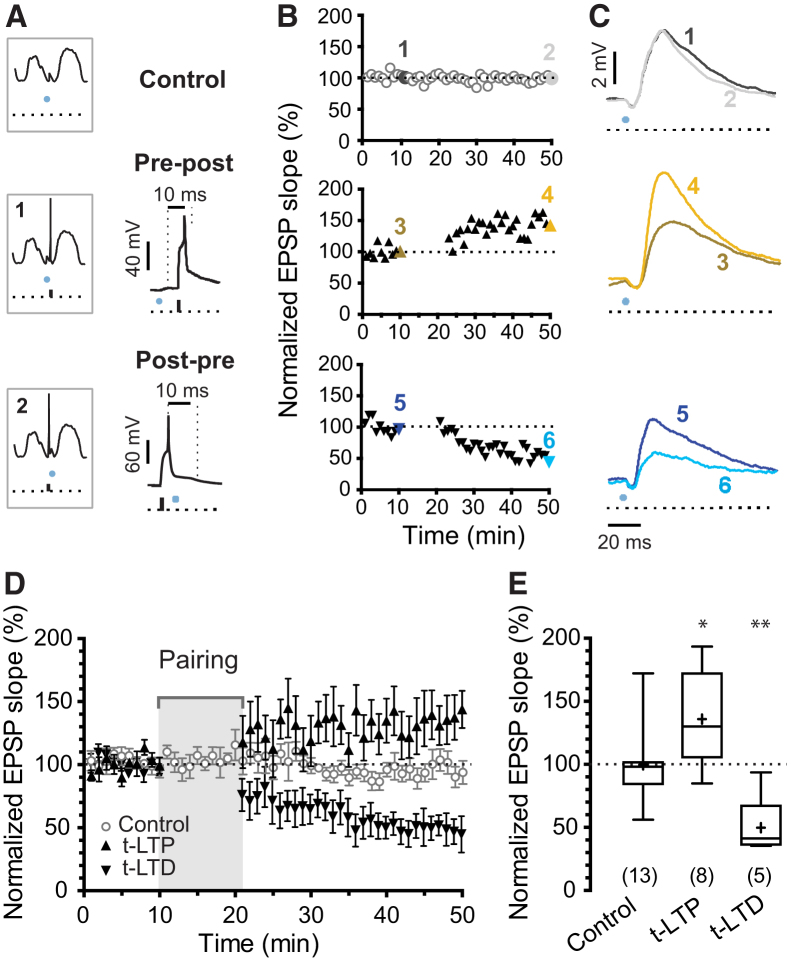
Synapse-Specific STDP Induced Using Light Stimulation during Down States In Vivo(A) Diagram of the protocols applied: top, control; middle, protocol 1 (pre-post); bottom, protocol 2 (post-pre).(B) Examples of each of the three experiments in (A). Symbols show 1-min means of the EPSP slopes normalized to the 10-min baseline.(C) Representative mean traces from the 10th (1, 3, and 5) and 50th min (2, 4, and 6) of recording.(D) Evoked EPSPs were stable over 50 min (<0.1 Hz, control; n = 13 cells in N = 10 mice, mean ± SEM). A pre-post pairing protocol applied during Down states led to t-LTP (n = 8 neurons in N = 8 mice, mean ± SEM), while a post-pre pairing protocol led to t-LTD (n = 5 neurons in N = 5 mice, mean ± SEM).(E) Summary of the results in (D). Number of recordings indicated in parentheses. Mean EPSP slope from last 5 min of recording was normalized to mean EPSP slope of the last 5 min of the baseline. The box and whisker plots represent maximum, upper quartile, mean (cross), median, lower quartile, and minimum values. One-way ANOVA and Dunnett’s post hoc test, ∗p < 0.05, ∗∗p < 0.01.